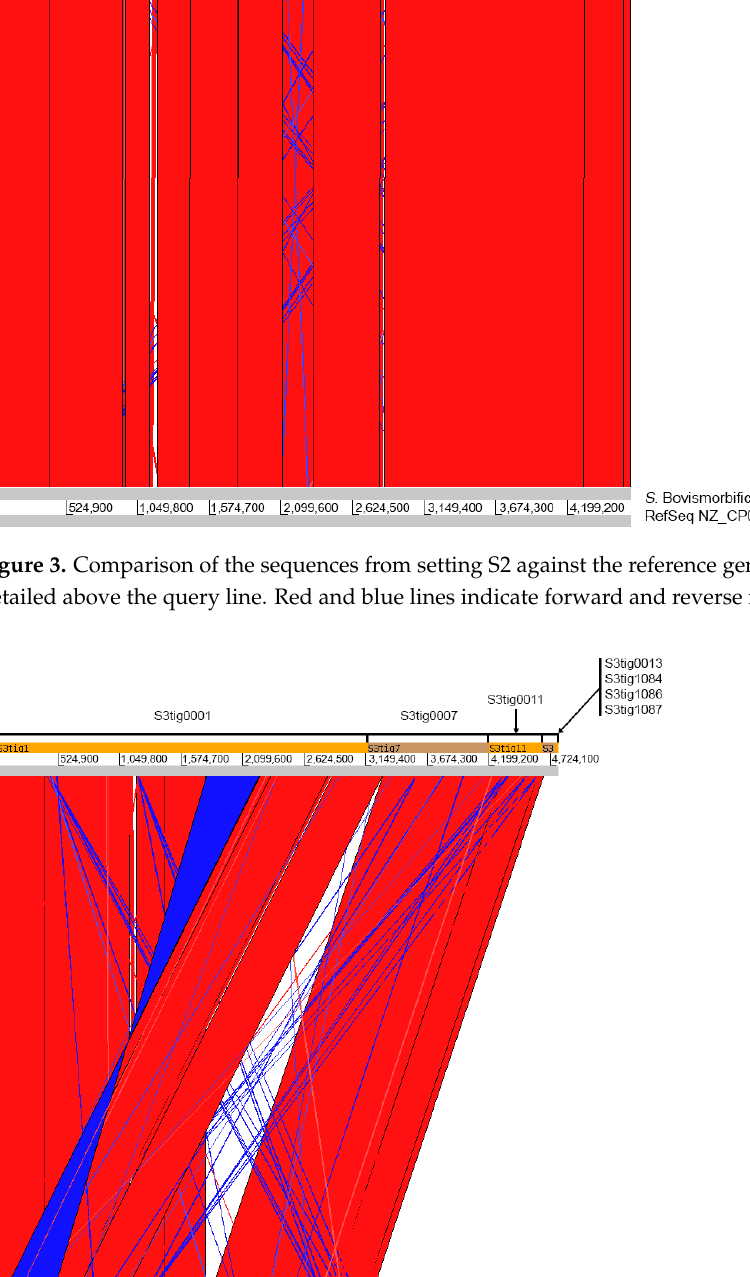
Figure 4. Comparison of the sequences from setting S3 against the reference genome. The contigs are detailed above the query line. Red and blue lines indicate forward and reverse matches, respec- tively.